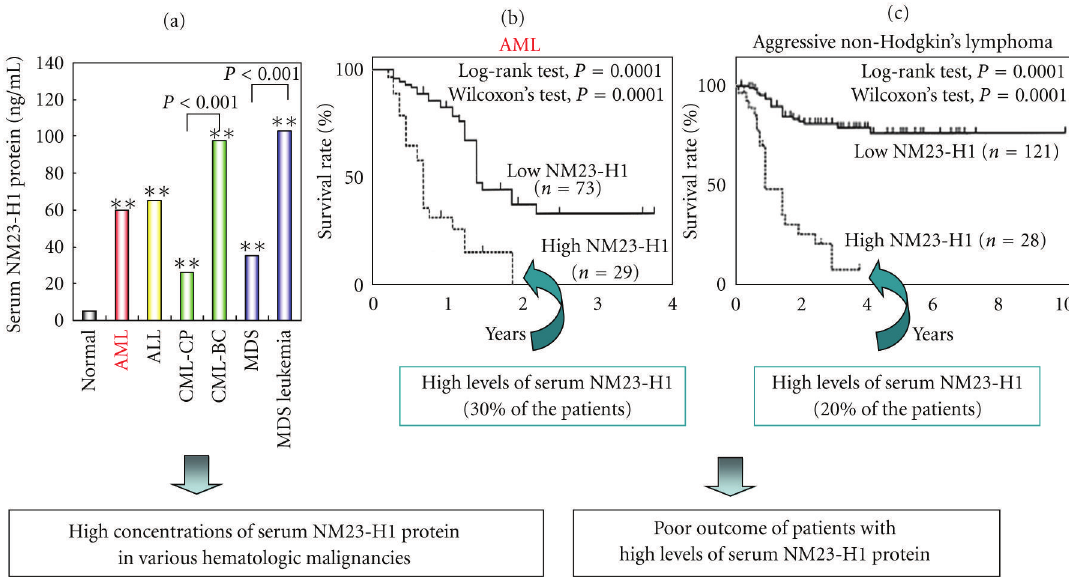
Figure 2: Clinical significance of extracellular NM23-H1 protein in hematologic malignancies. (a) Serum NM23-H1 protein levels in normal healthy control and hematologic malignancies [31]. Normal control ( n = 21), AML ( n = 102), ALL ( n = 6), CML-CP ( n = 13), CML-BC ( n = 9), and MDS ( n = 12), MDS overt leukemia ( n = 6). Mann-Whitney’s U test versus control, ∗∗ P < 0 . 001. (b) Overall survival curves of patients with AML [32]. High-NM23-H1 ( ≥ 80ng/mL) patients ( n = 29) had a worse prognosis than low-NM23-H1( < 80ng/mL) patients ( n = 73). (c) Overall survival curves of patients with intermediate and high-grade non-Hodgkin’s lymphoma [11, 25]. High-NM23-H1 ( > 80ng/mL) patients ( n = 28) had a worse prognosis than low-NM23-H1( < 80 ng/mL) patients ( n = 121).